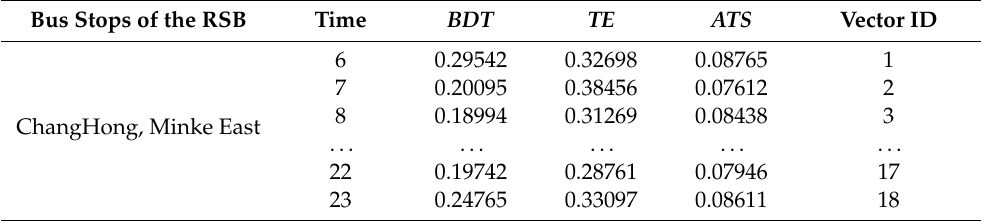
Table 1. Example vectors of one RSB (road segment between bus